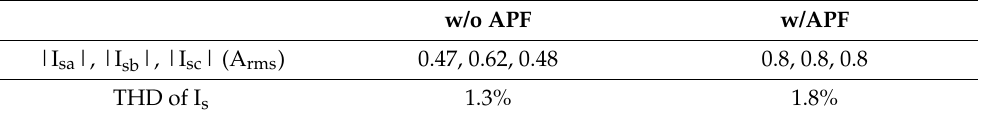
Table 8. Magnitudes and THD of the source currents.